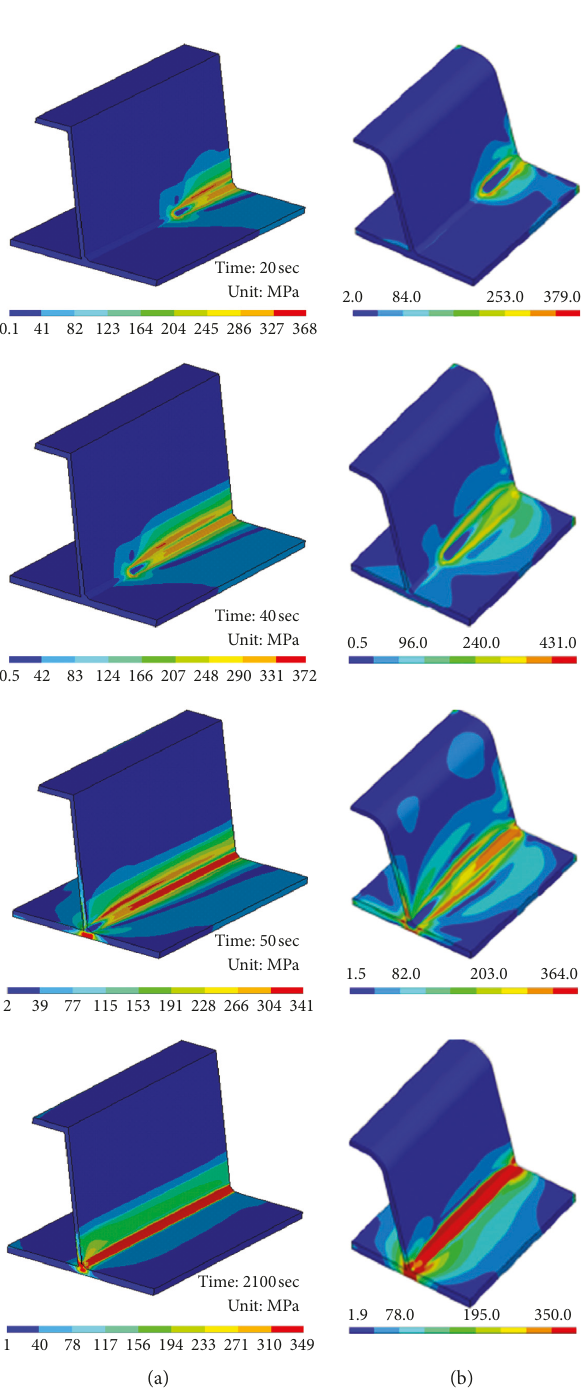
Figure 14: The equivalent stress clouds at different times of the welding process at the connection of the U-rib and the top deck. (a) The simulation result in this paper. (b) Results in reference